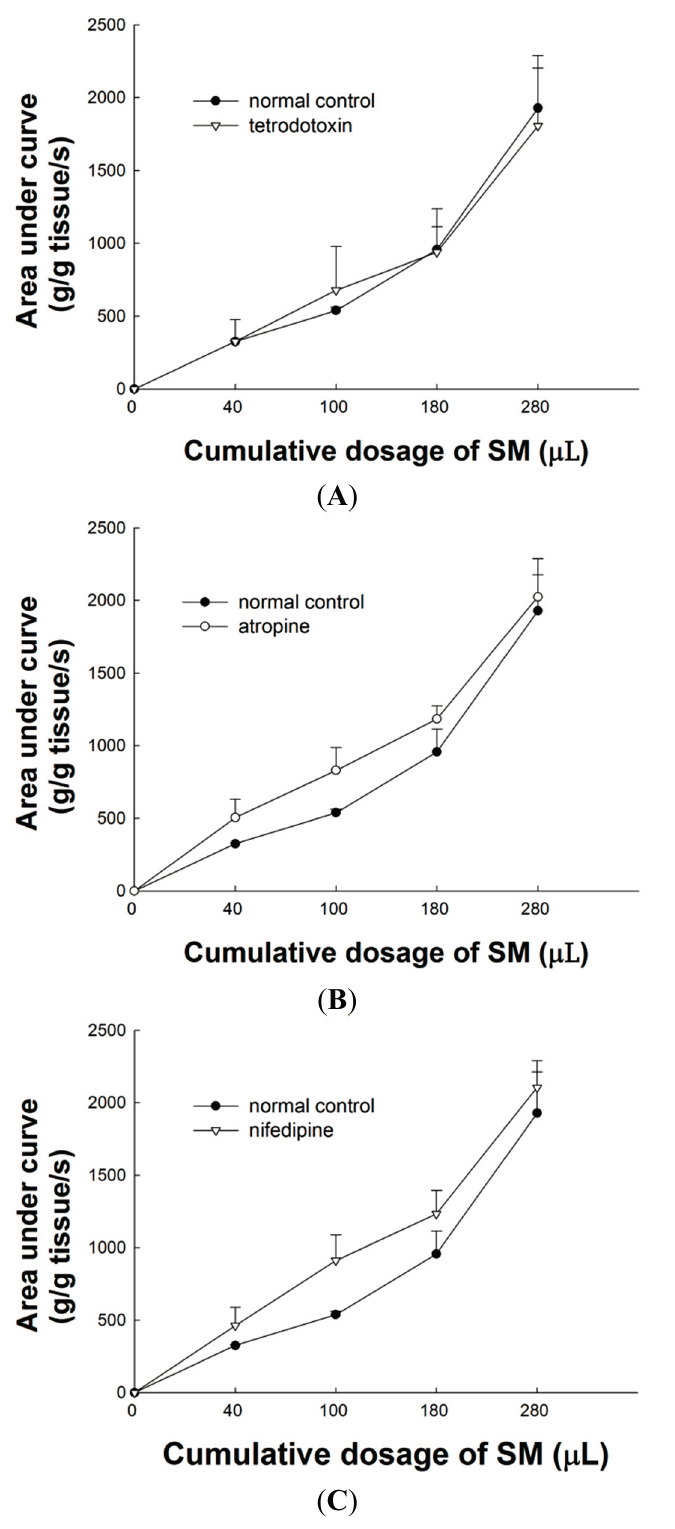
Figure 2. Effects of pretreatment with TTX, atropine and nifedipine on contraction of LES induced by SM extracts. ( A ) TTX (10 − 6 M) has no significant effect on contraction of LES induced by SM extracts; ( B ) Atropine (10 − 6 M) has no significant effect on contraction of LES induced by SM extracts; ( C ) Nifedipine (10 − 6 M) has no significant effect on contraction of LES induced by SM